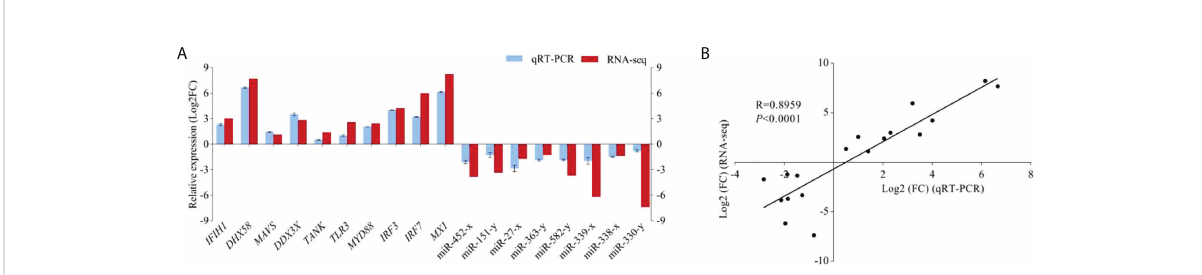
FIGURE 6 Validation of DEGs and DEMs by qRT-PCR. (A) The expression comparison of DEGs and DEMs in RNA-seq and qRT-PCR. Error bars indicate standard deviation. Fold-change of qRT-PCR data represents the ratio of DEGs/DEMs expression values for T48L group vs. C48L group after normalization against b -actin / U6 . (B) The Pearson correlation analysis between qRT-PCR and RNA-seq results (R = 0.8959, P < 0.0001). The X- axis represents the Log2 (FC) value from qRT-PCR. The Y-axis indicates the Log2 (FC) value from RNA-seq.